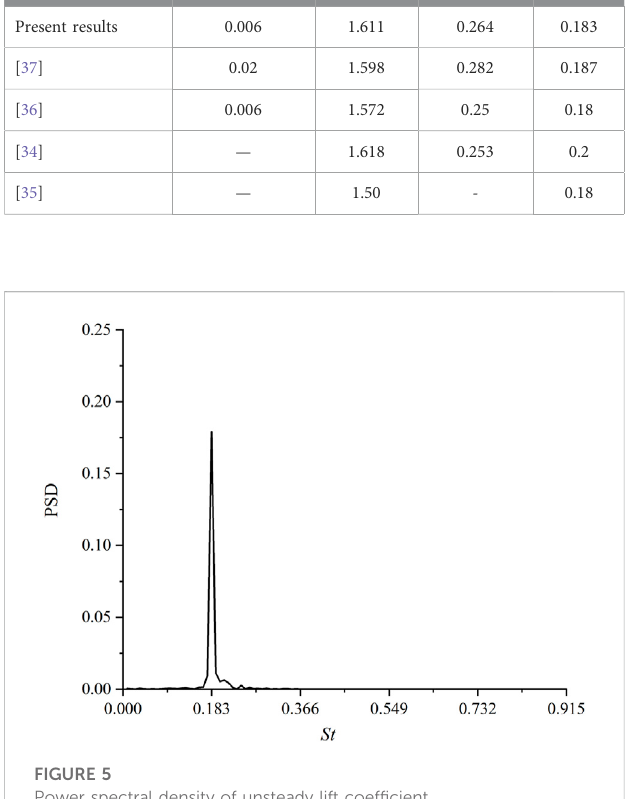
FIGURE 5 Power spectral density of unsteady lift coef fi